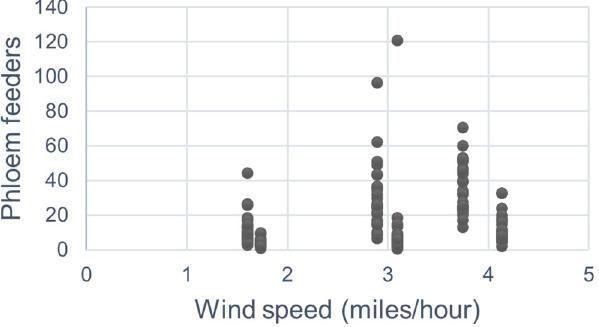
Fig 3. Scatterplot of number of phloem feeder and average 7-day windspeed for six dates in 2015 and 2016. https://doi.org/10.1371/journal.pone.0246855.g003 groups, corresponding with the first, second and third collections each year (n = 162 for each group). Exploratory regression indicated that seasonal models were better fitting than the global OLS models (Table 10) where, most notably AICc values were much smaller. However, measures of multicollinearity (VIF values) remained high, especially for the mid-season model, likely due to the interaction between soil texture and water availability in the context of two very different precipitation regimes captured during the two-year study. The Joint Wald